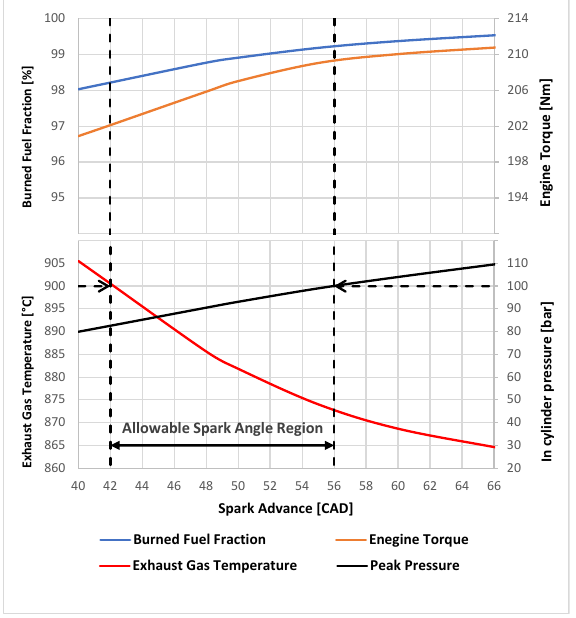
Figure 9. In-cylinder pressure, burned fuel fraction, exhaust gas temperature and engine torque versus spark advance. Engine speed: 3000 rpm, boost pressure: 1.6 bar. For this engine operating point, the maximum torque spark advance is 66.9 crank angle degrees, and the knock intensity is always zero. The allowable spark advance region is determined by constraints on the peak pressure and exhaust gas temperature. Table 6. Engine recalibration at 3000 rpm, boost 1.6.